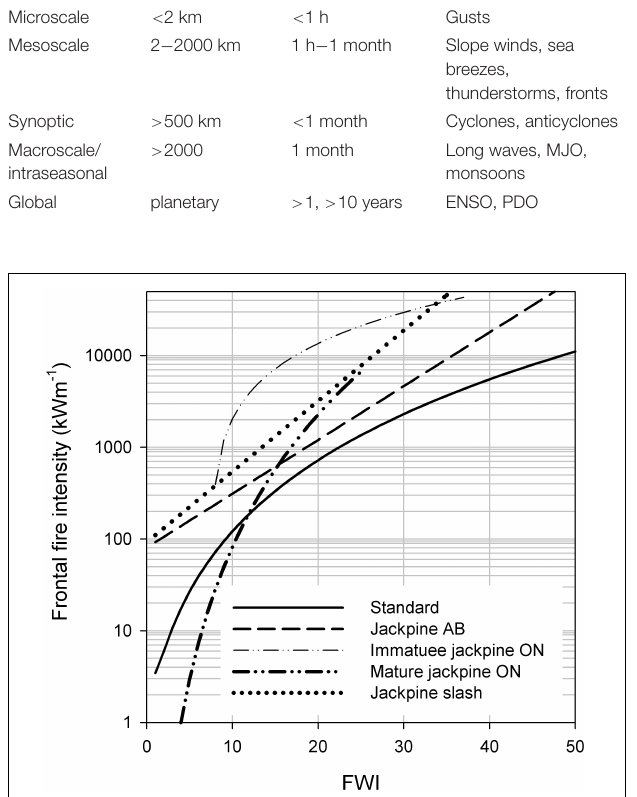
FIGURE 1 | Relationship between the FWI of the Canadian Forest Fire Weather Index System and frontal fire intensity (kWm − 1 ) predicted by the standard scaling equation (Van Wagner, 1987) and observed in 4 fuel complexes in Alberta (AB) and Ontario (ON) Canada (Stocks and